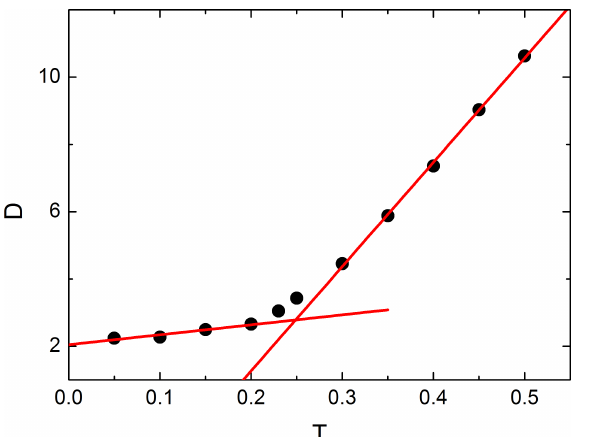
Figure 14. Temperature dependence of parameter D , Equation (8). Solid lines represent linear fits. The second approach, based on the probability densities ρ ( V ( (cid:126) r )) (Figure 6) and ρ ( D ( (cid:126) r )) (Figure 13), offers an elegant, geometric-based criterion for the glass transition temperature. Namely, both plots display sharp peaks located at V ( (cid:126) r ) = D ( (cid:126) r ) = 0,